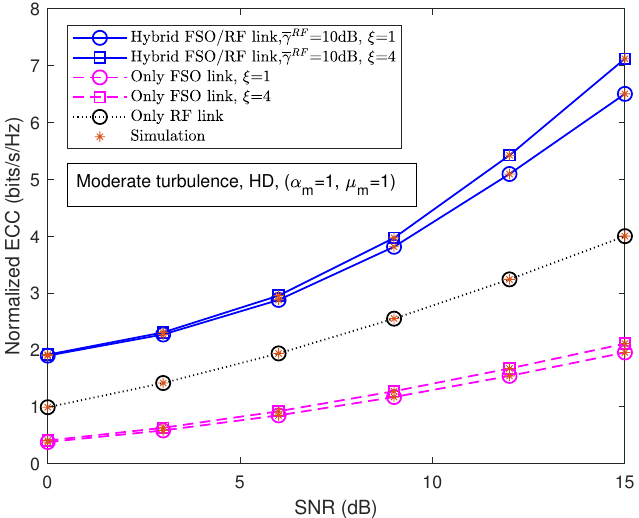
Figure 5. Relationship between channel capacity and SNR of the hybrid system, only FSO system and only RF system under different pointing errors and moderate